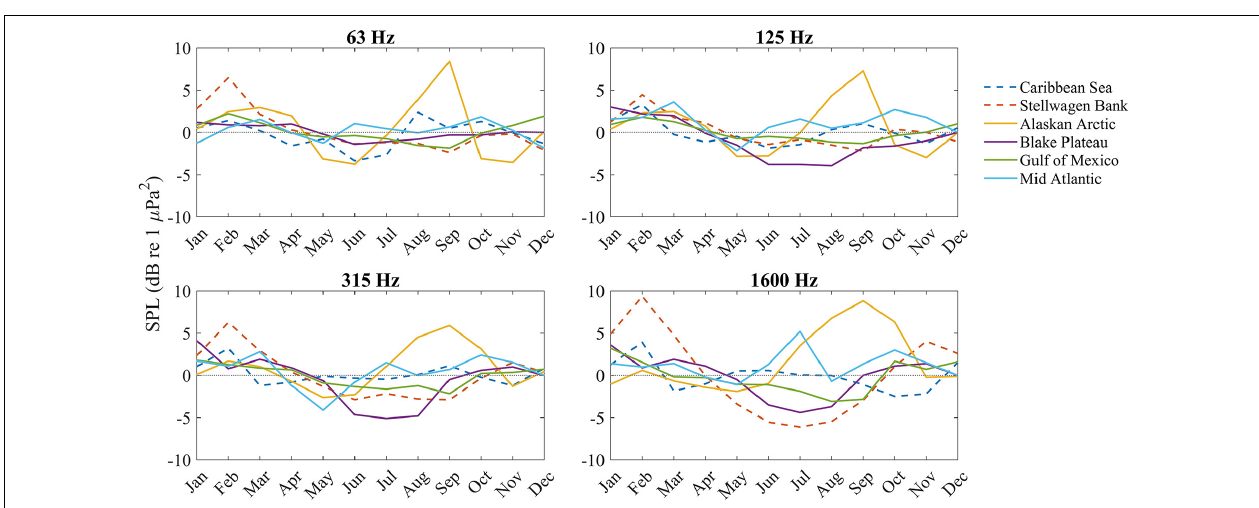
FIGURE 4 | Monthly median anomalies for the 63, 125, 315, and 1,600 Hz decidecade bands. Lines above zero (gray dotted line) indicate that that month’s median sound level was higher than the median sound level for all months recorded in that band. Lines below zero indicate a lower median sound level for that month compared to the median across all months. Dashed lines indicate a shallow water site while solid lines indicate a mid or deep water site. Data from Hawaiian Islands, Olympic Coast, and American Samoa are not included because the deployments did not span a full 12-month